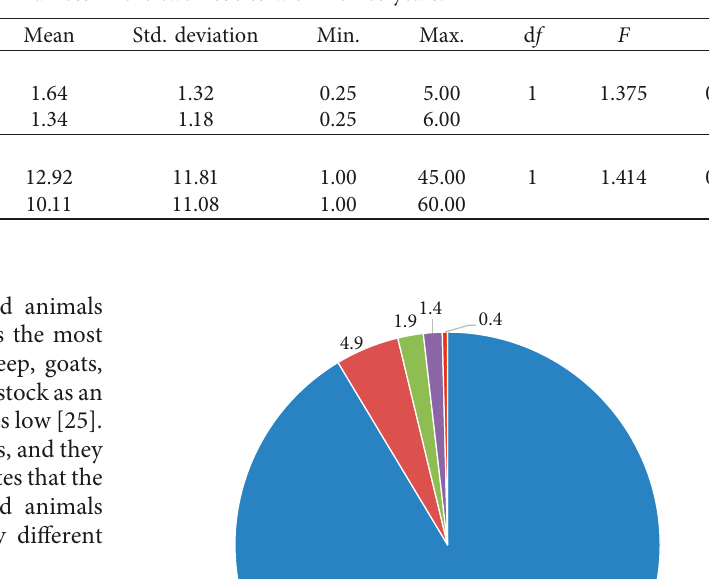
Table 5: Crop and animal loss in the two kebeles within three years.